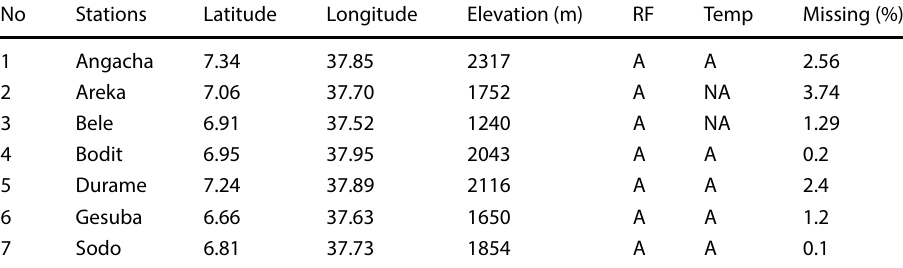
A = available NA = not